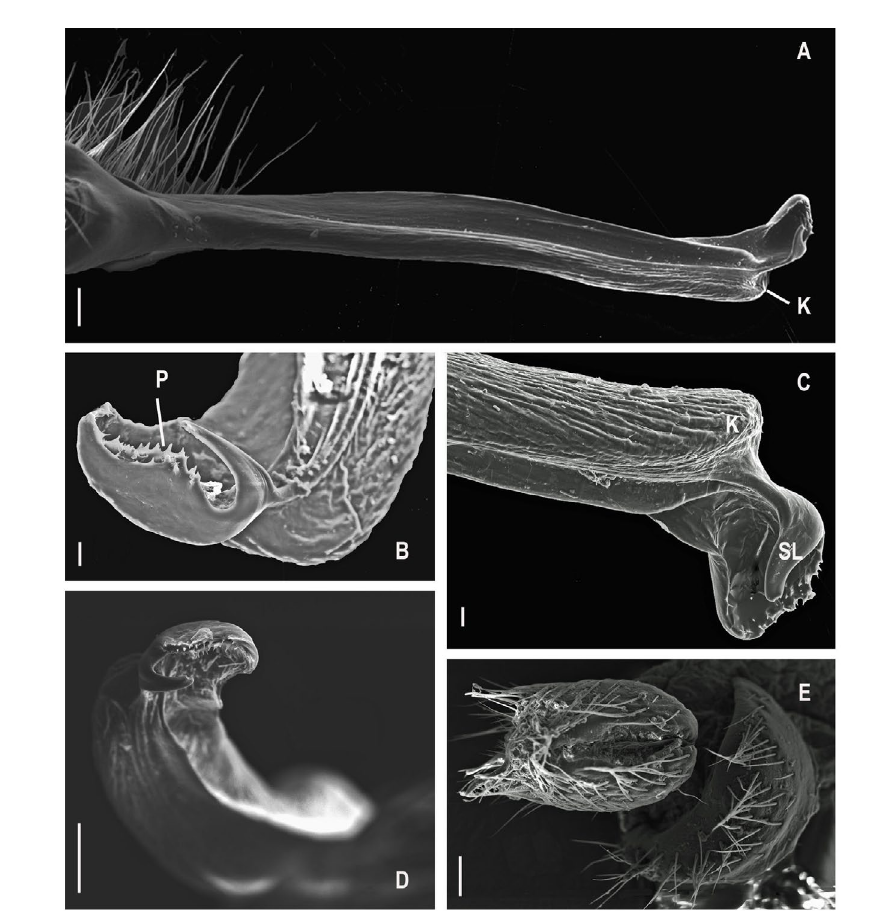
Fig. 8. Levizonus nakhodka Mikhaljova sp. nov., ♂♂, paratypes (FSCB 22020, FSCB 112020) and ♀, paratype (FSCB 122020). A . Gonopod telopodite, lateral view. B , D . Gonopod apex from slightly different angles, ventral view. C . Distal part of gonopod, lateral view. E . Vulva, mesal view. Scale bars: A, D–E = 200 μm; B, C = 20 μm.